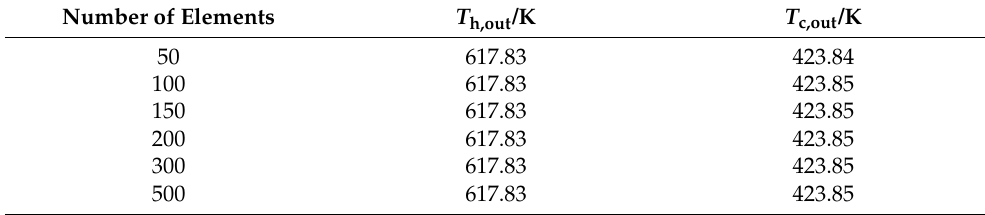
Table 1. The element independence